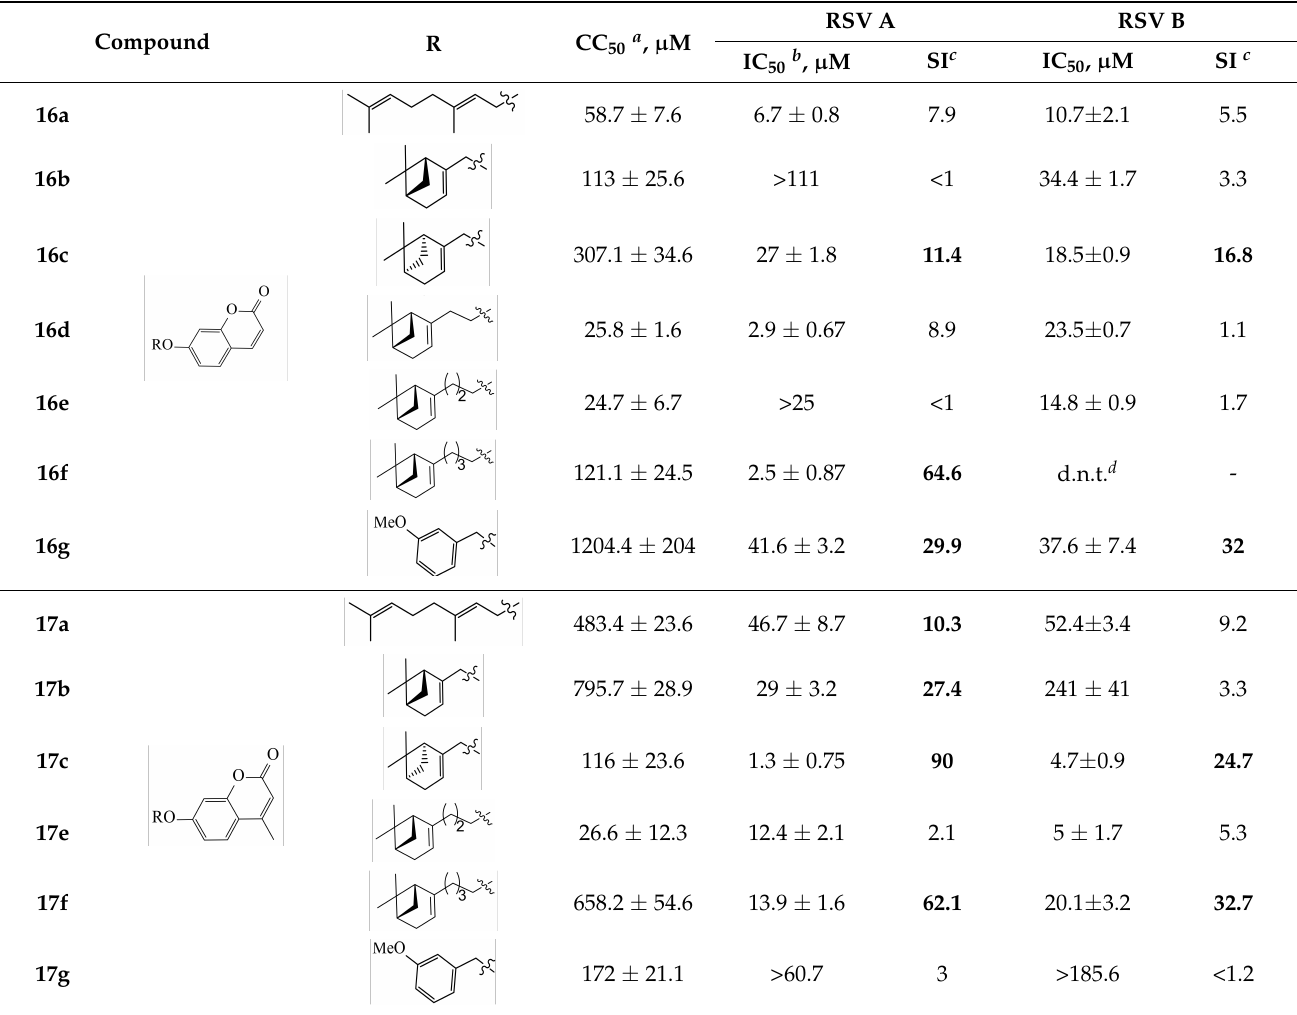
Table 1. Antiviral activity and cytotoxicity of compounds 16 – 18 , 25 – 27 against RSV A and B.